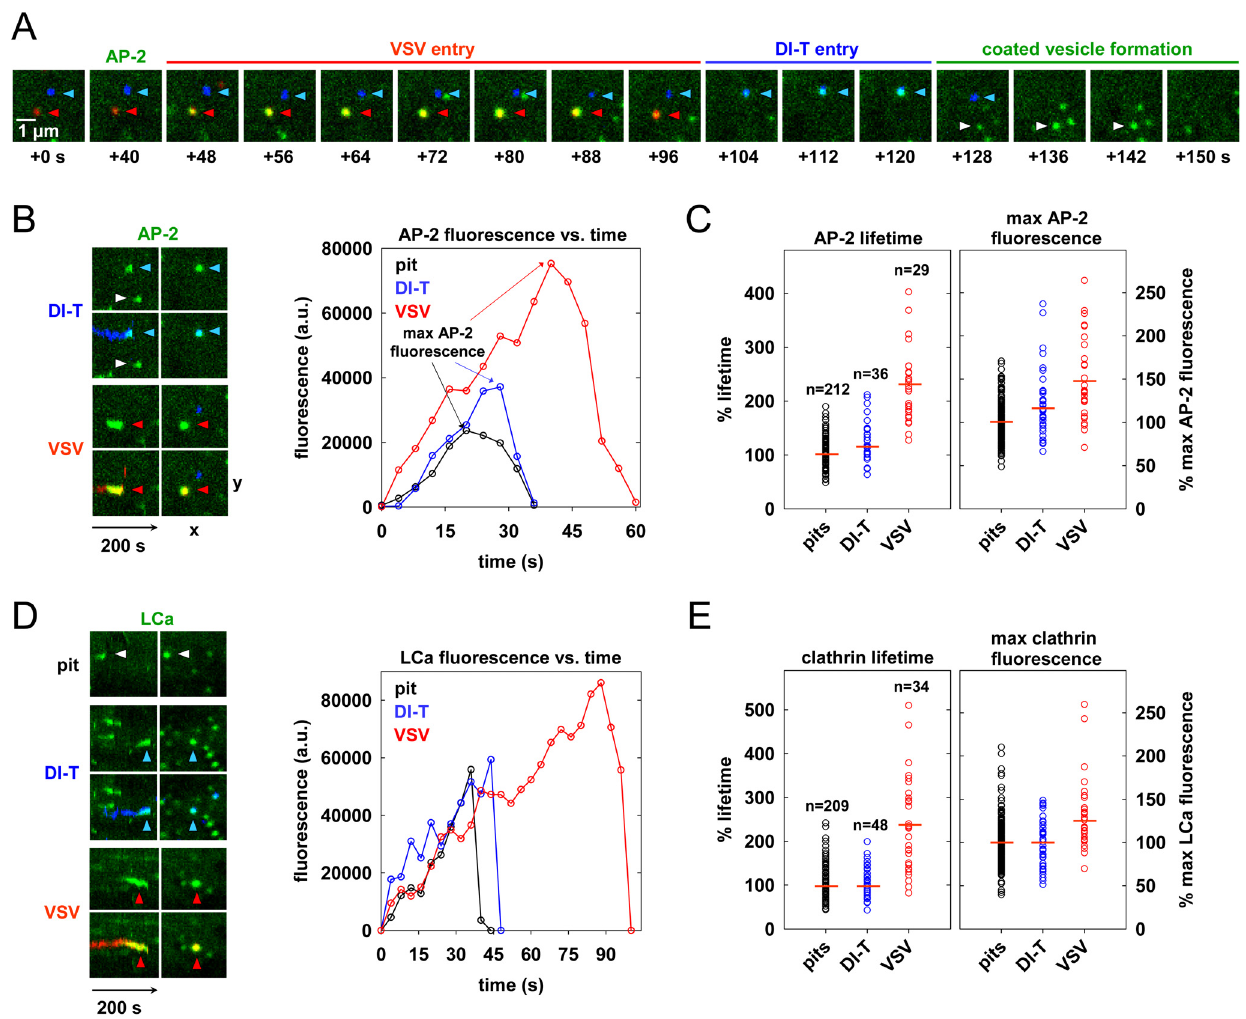
Figure 3. Cells internalize DI-T particles using conventional clathrin-coated vesicles. (A) Internalization of VSV and DI-T by the same cell. BSC1 cells stably expressing s 2-eGFP (green) were inoculated with VSV (red) and DI-T (blue) particles, and confocal images were captured at 4 s intervals. The images show the sequential internalization of single VSV (red, red arrowheads) and DI-T (blue, blue arrowheads) particles, followed by the formation of a canonical coated vesicle (white arrowhead) within a 3.5 6 3.5 m m 2 area of the plasma membrane (Video S2). The first acquired frame of the time-lapse series is designated + 0 s, and the capture time of the subsequent images is shown. (B) AP-2 recruitment during the uptake events shown in A. Left, image quadrants depicting AP-2 accumulation over time (left panels) and at the time of maximum AP-2 signal during each event (right panels). Upper panels in each quadrant show the AP-2 channel alone, and the lower panels show overlays of the virus and AP-2 channels. The highlighted pit from A. is indicated with a white arrowhead, and virus particles are colored as in A. Right, fluorescence intensity (in arbitrary units, a.u.) of AP-2 over time for the events shown at left and in A. The time of AP-2 detection above the local background was set to t=0 s for each event. (C) Kinetics and AP-2 content of endocytic structures. The plots show the relative lifetime (left) and maximum fluorescence intensity (right) of AP-2 during the uptake of coated pits lacking virus (pits, black) or structures that internalized DI-T (blue) or VSV (red) particles (from 4 cells). Values are expressed as percentages to facilitate comparison of viral and nonviral uptake events across multiple cells. Approximately 50 pits lacking virus were analyzed in each cell, and the mean of the measured values was calculated for each parameter. The values for each nonviral and viral uptake event were divided by the mean for pits lacking virus in the same cell, and the resulting values were multiplied by 100. Each open circle represents a single uptake event, and horizontal red lines demark the mean of the compiled population. The number of events is provided above each plot. Numerical values and statistical analyses are provided in Table 1. (D) Clathrin recruitment during virus entry. Left, kymograph views of internalization events from a single BSC1 cell transiently expressing eGFP-LCa (Videos S3, S4). Images were captured as in A. and displayed as described in B. Right, fluorescence intensity of eGFP-LCa over time for the events shown at left. (E) Kinetics and clathrin content of endocytic structures. The plots show the relative lifetime (left) and maximum fluorescence intensity (right) of clathrin during the uptake of coated pits lacking virus (pits, black) or structures that internalized DI-T (blue) or VSV (red) particles (from 3 cells). Data were calculated and plotted as described in C. Numerical values and statistical analyses are provided in Table 1.